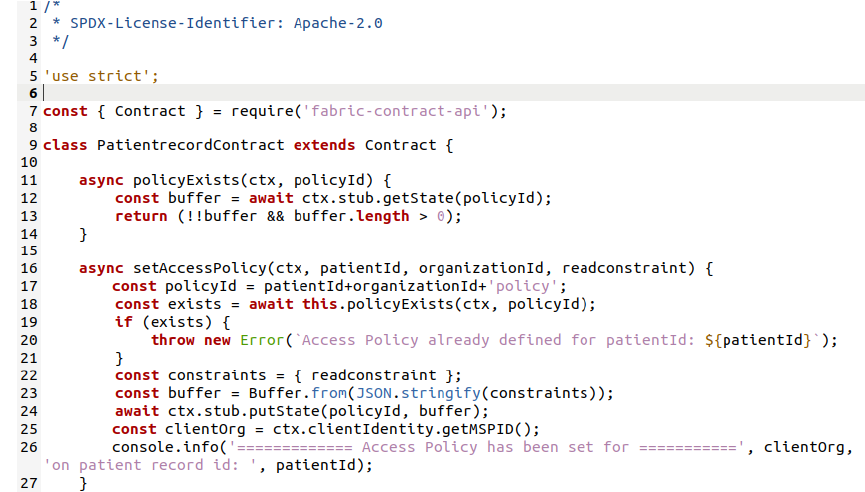
Figure 11. Smart-contract code using Node.js.